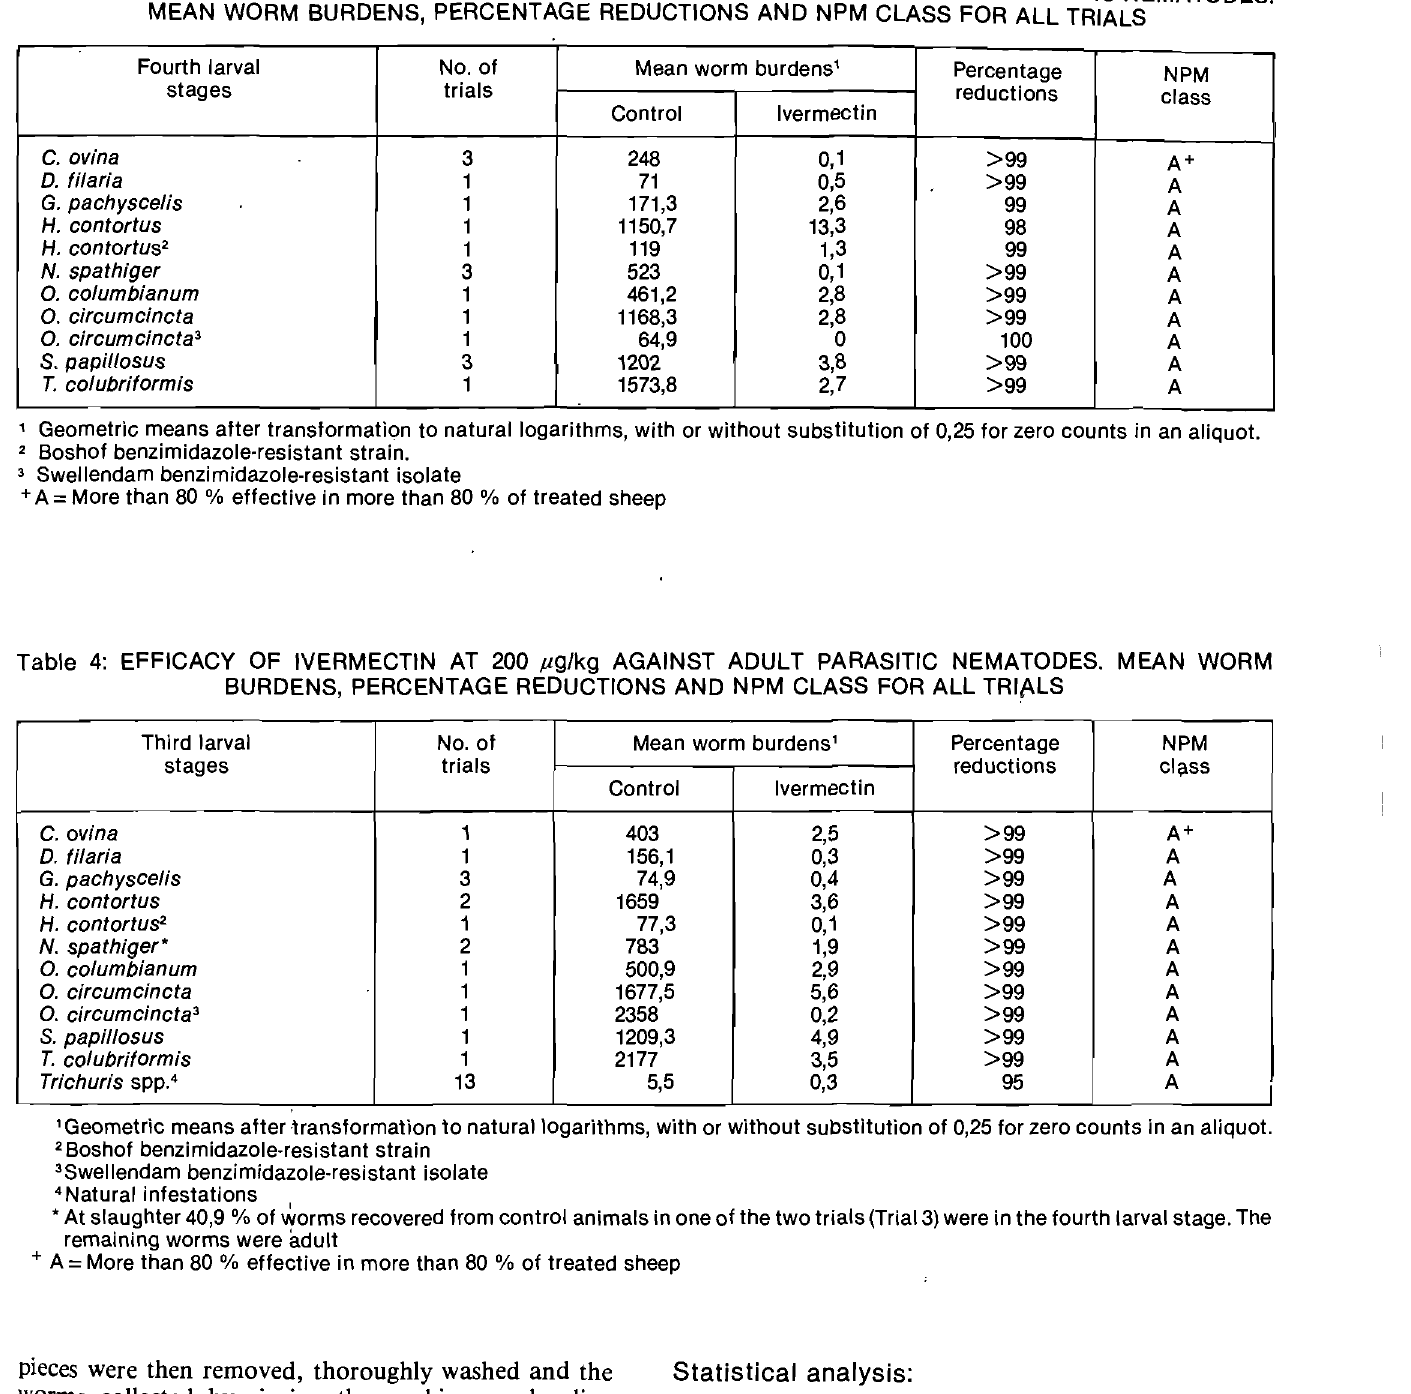
Table 4: EFFICACY OF IVERMECTIN AT 200 tlg/kg AGAINST ADULT PARASITIC NEMATODES. MEAN WORM BURDENS, PERCENTAGE REDUCTIONS AND NPM CLASS FOR ALL TRIALS Third larval No.